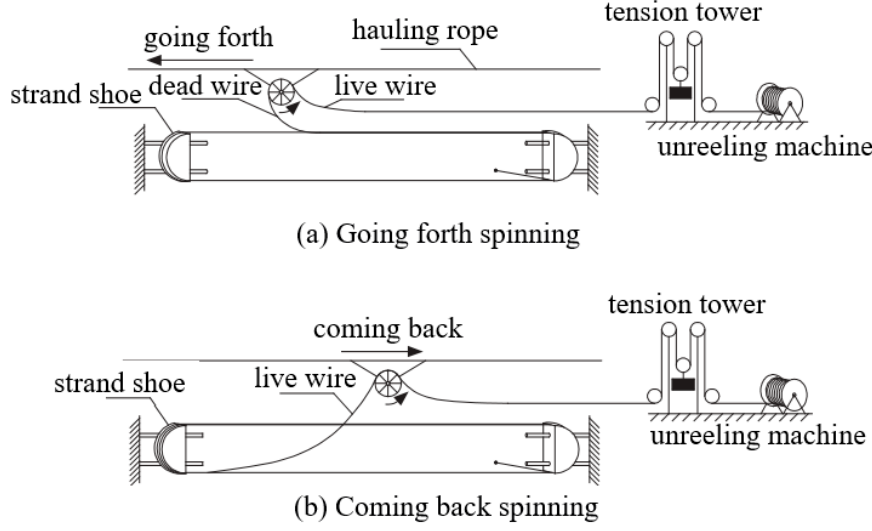
Figure 8. Construction principle of the AS method.